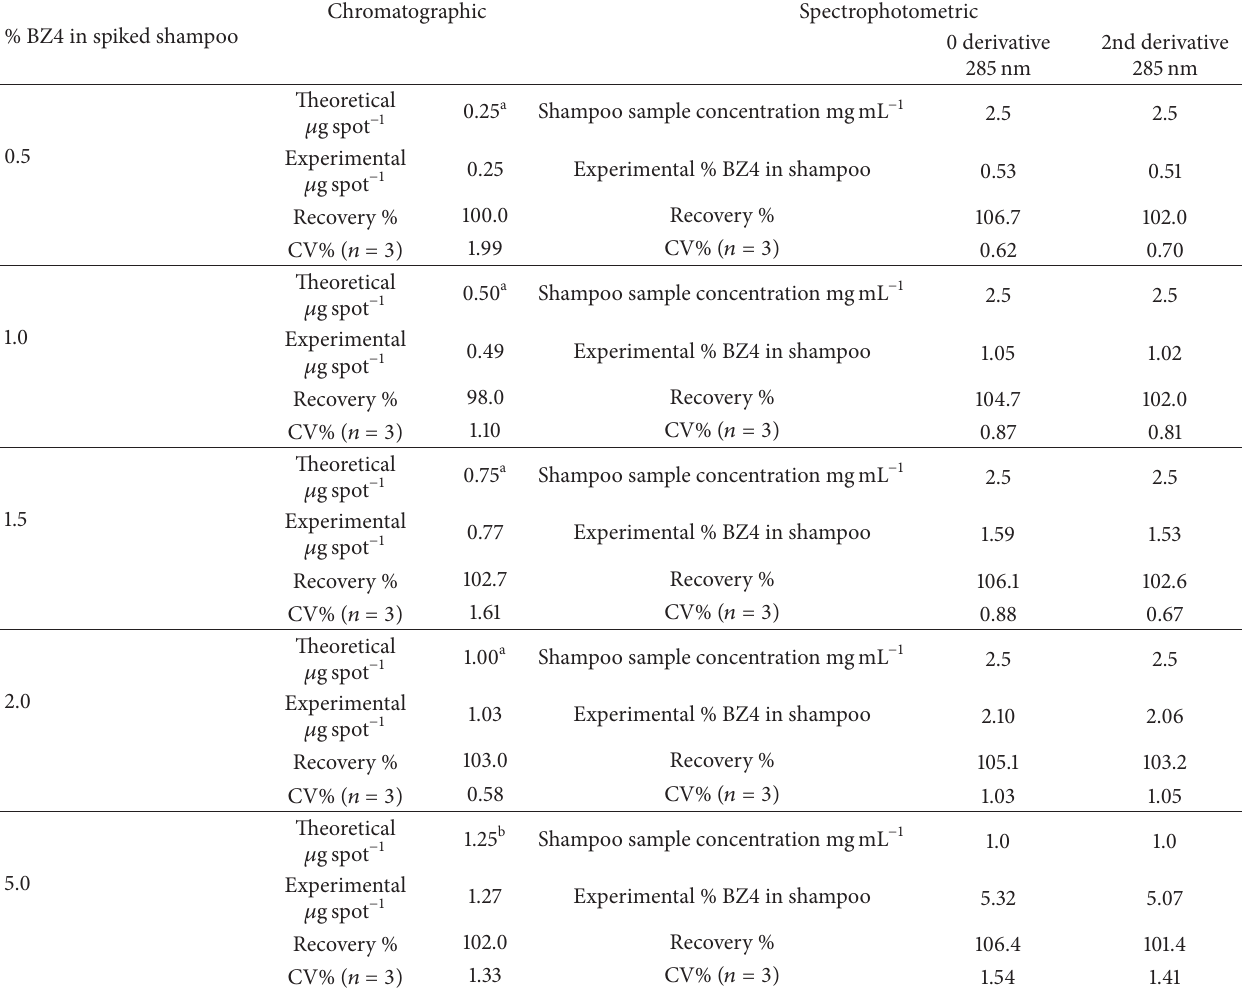
Table 3: Recovery